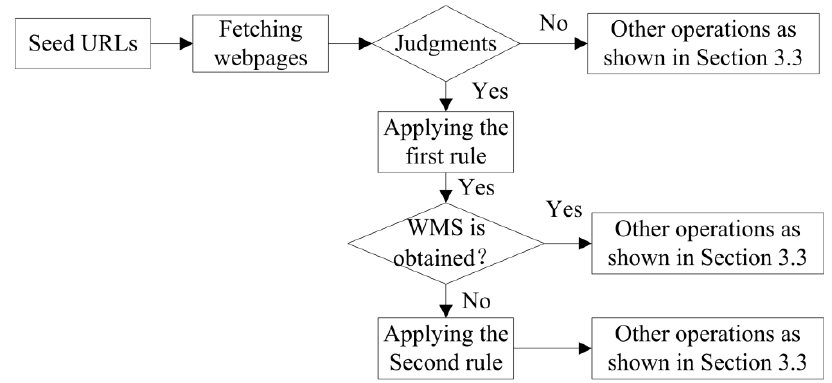
Figure 4. Instructions of the two JavaScript invocation rules.